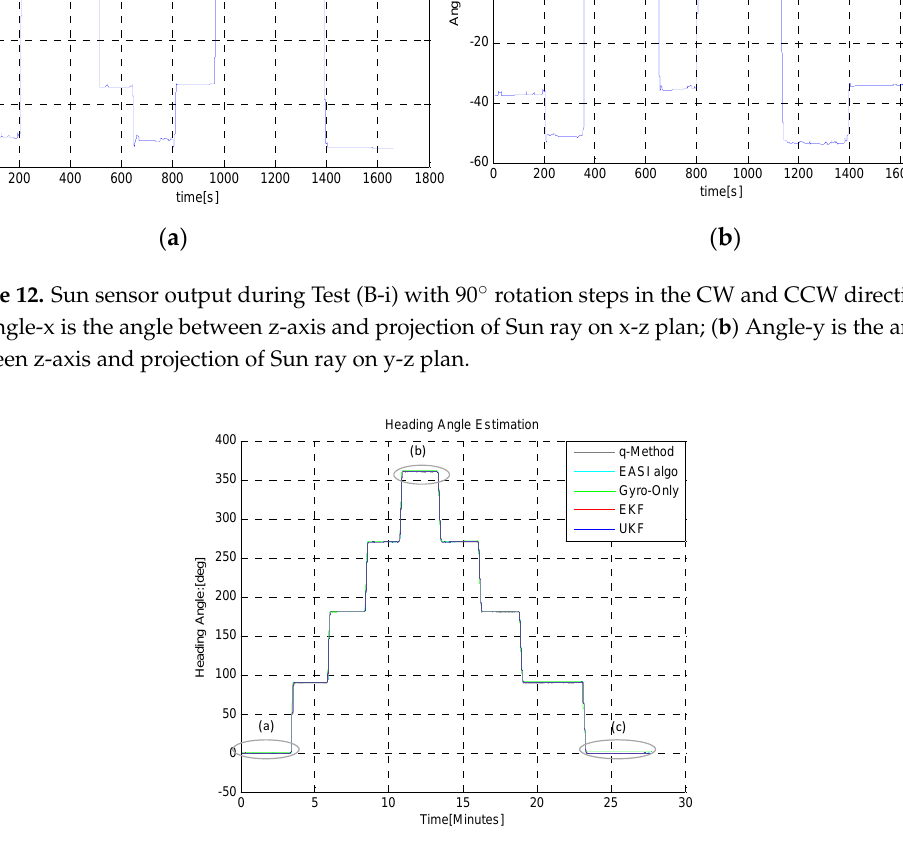
Figure 13. TiP with large steps (90°) in CW and CCW. Comparison of heading estimation algorithms.